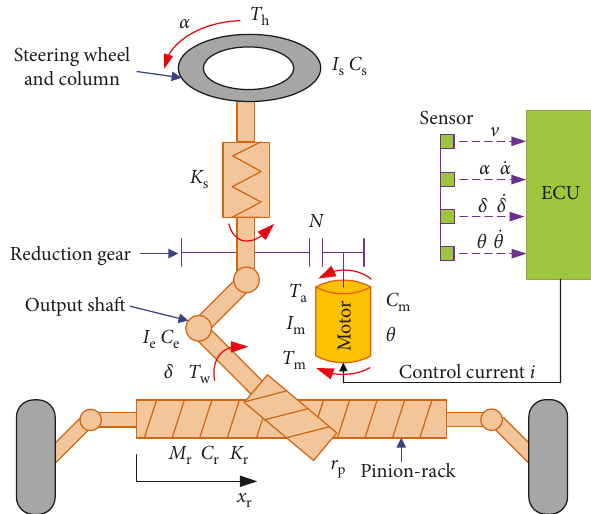
Figure 1: Electric power steering